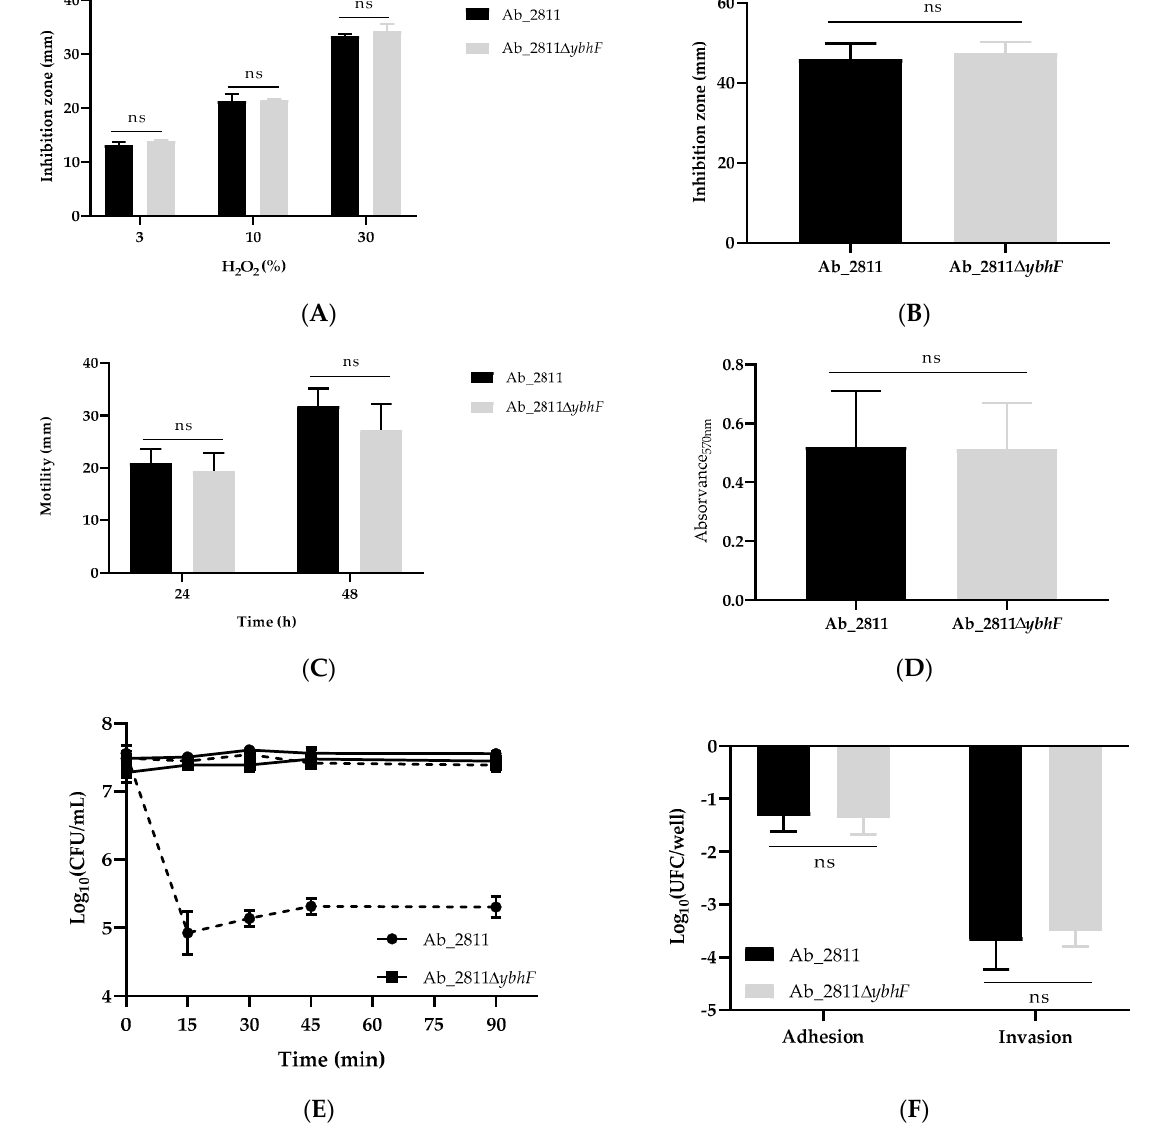
Figure 3. Evaluation of determinant virulence factors for parental strain Aliarcobacter buzleri Ab_2811 and mutant strain Ab_2811 ∆ ybhF . Susceptibility to oxidative stress after 48 h of incubation, induced by ( A ) hydrogen peroxide and ( B ) methyl viologen. ( C ) Motility ability at 24 and 48 h of incubation. Data correspond to the mean ± SD. ( D ) Biofilm formation ability after 48 h of incubation, under microaerophilic conditions. ( E ) Susceptibility to human serum over 90 min of incubation, corresponding the solid lines to the incubation of bacteria with inactivated serum and dash lines with non-inactivated serum. ( F ) Adhesion and invasion assays in the Caco-2 cell line. Data correspond to the mean ± SEM considering at least three independent assays. ns: p > 0.05 by Student’s t test.